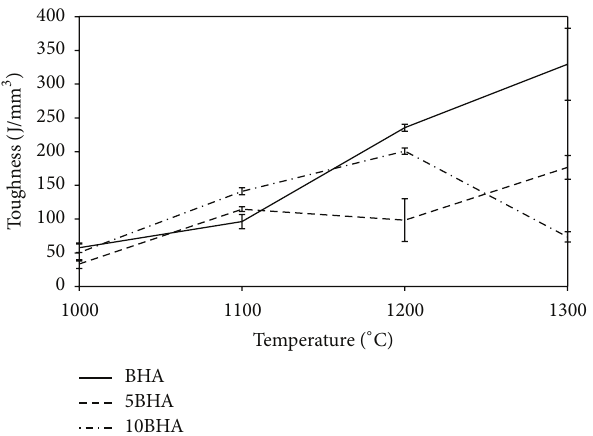
Figure 13: Variation of fracture toughness of BHA, 5BHA, and 10BHA composites at different sintering